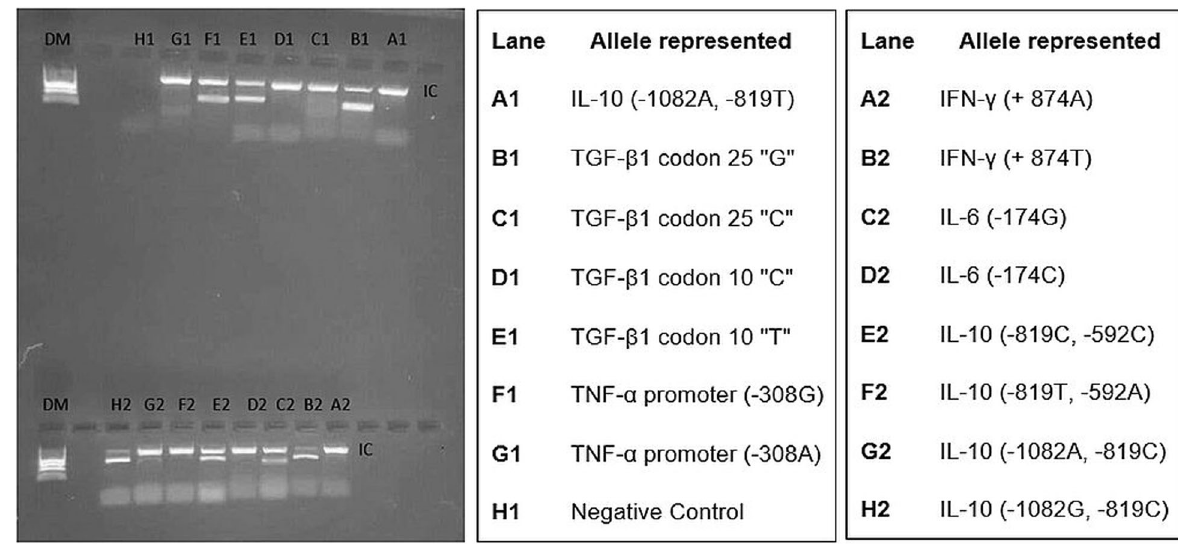
Fig. 1 Cytokine genes SNPs genotyping by PCR-SSP. Five cytokine genes SNPs including TNF- α promoter -308G>A, two TGF- β 1 SNPs; codon